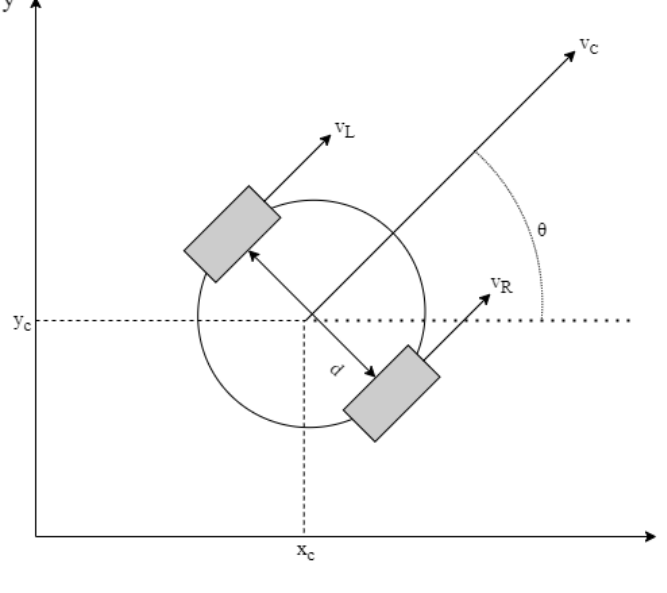
Figure 4. Diagram of the QBot 2e mobile